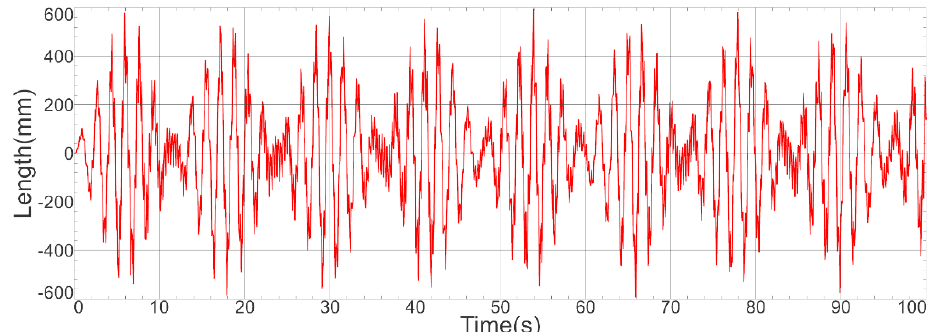
Figure 9. Vibration amplitude in time for the first story recorded on the sensor Se_M4D. Analyzing the diagram (Figure 9), it can be observed that the building get into resonance (rumbling) and there is a large amplitude of building vibrations (up to 600 mm).